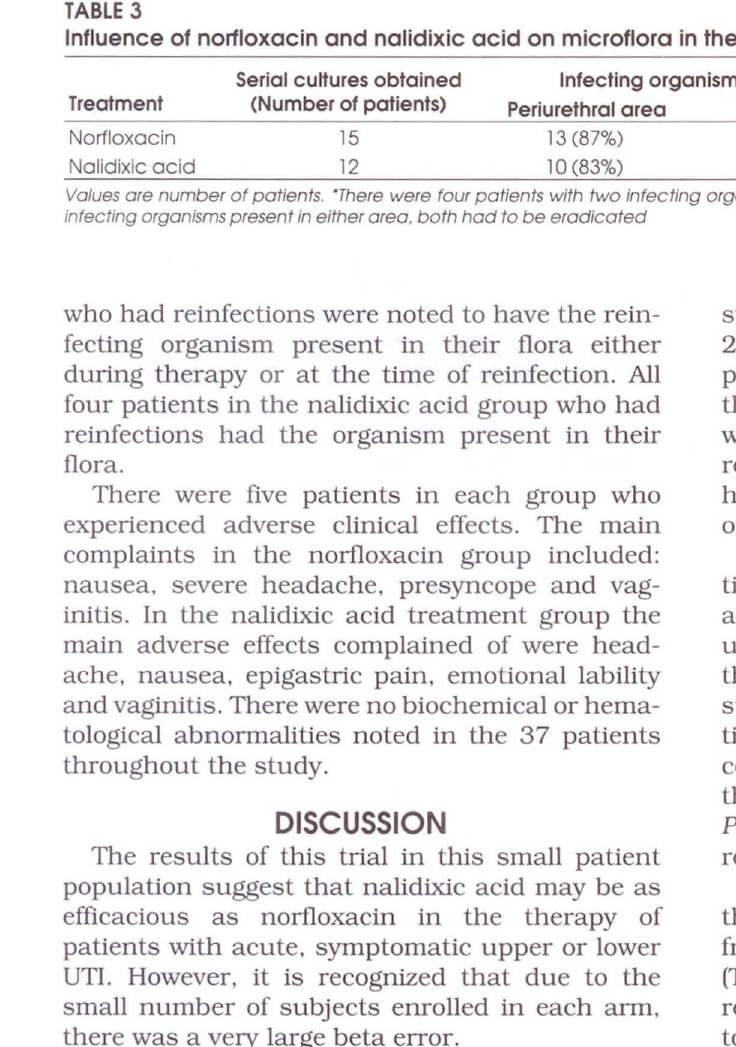
Influence of norfloxacin and nalidixic acid on microflora in the periurethral area and the anal canal Serial cultures obtained Infecting organism present• Infecting organism eradicatedt Treatment (Number of patients) Periurethral area Anal